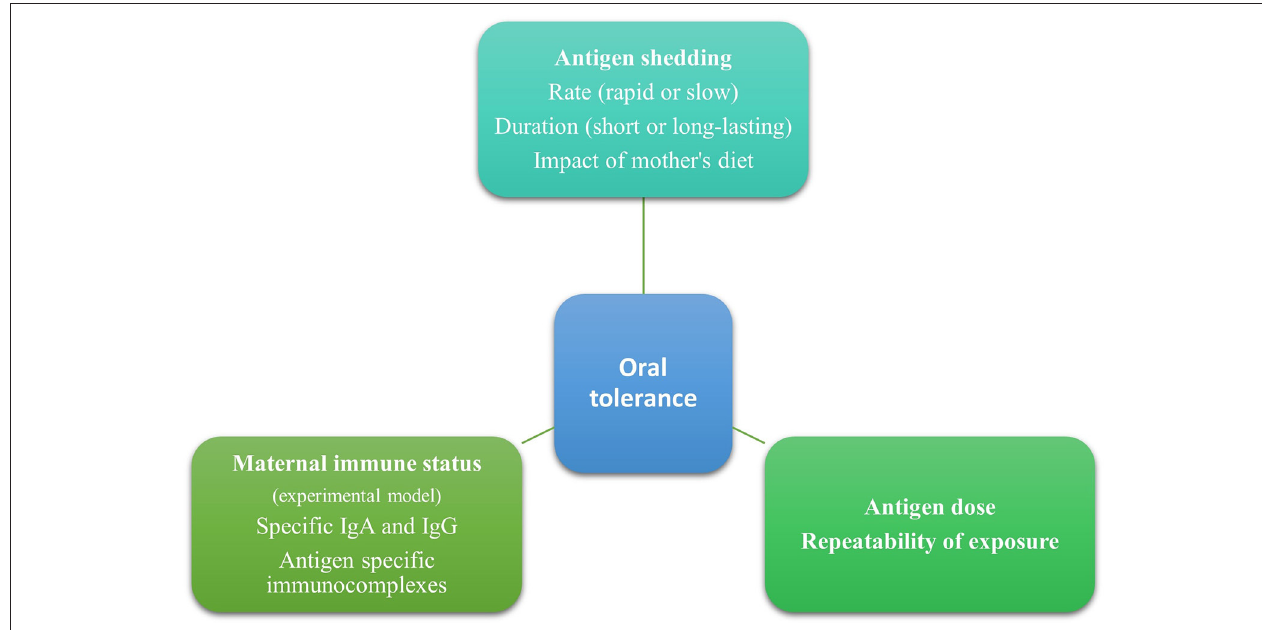
FIGURE 1 | Antigen characteristics in human milk that may affect oral tolerance induction.